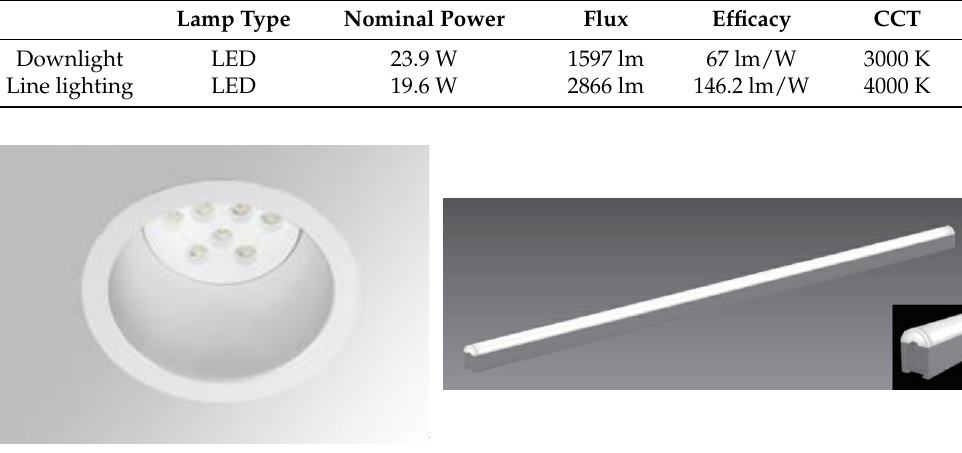
Figure 20. The lighting fixtures used in the simulation (( Left ): Downlight, ( Right ): Line lighting). Table 7. Specifications of lighting fixtures.